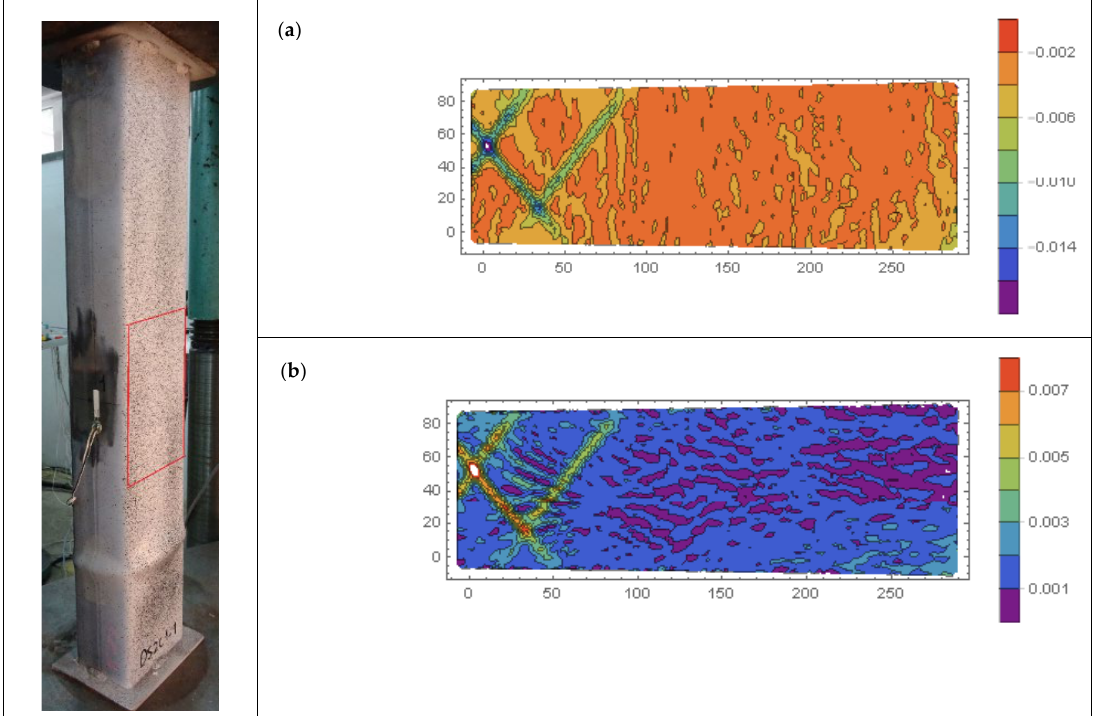
Figure 22. ( a ) Longitudinal ε xx and ( b ) transverse ε yy strains in column DS2C1_1 captured in the same point of the equilibrium path.